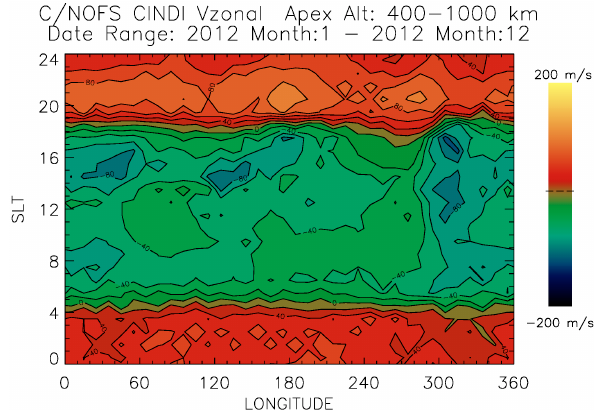
428 Figure 2. Contour plot of CINDI zonal velocities versus SLT (hours) and longitude 429 for the year 2012. All available data in the 400–1000 km apex altitude range was 430 Fig. 2. Contour plot of CINDI zonal velocities versus SLT (hours) used. A positive value represents eastward drift. 431 and longitude for the year 2012. All available data in the 400– 432 1000km apex altitude range were used. A positive value represents eastward